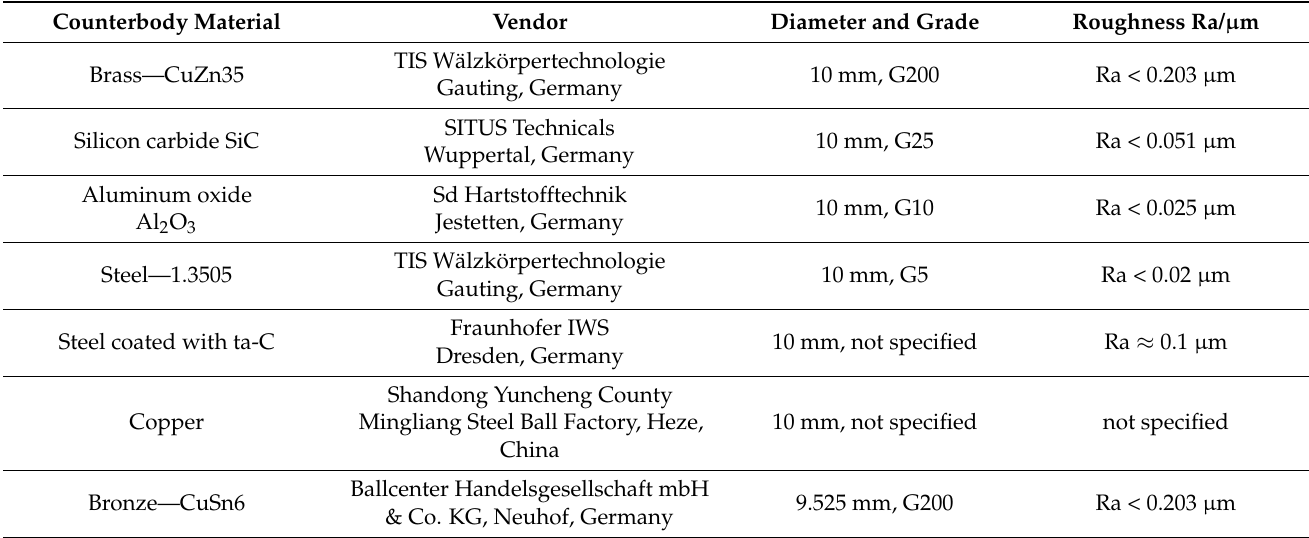
Table 1. Counterbody ball materials, vendor, diameter, grade specification, and roughness. The roughness of the counterbodies is calculated from the manufacturer’s grade in Ra (arithmetical mean height of a